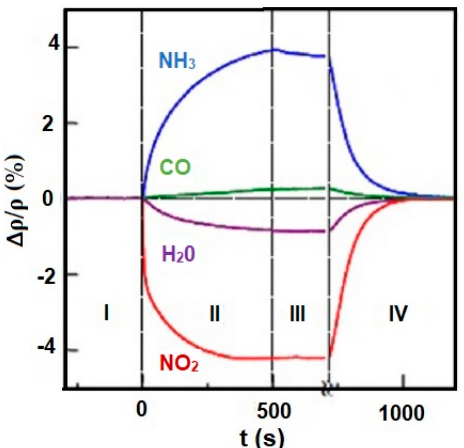
Figure 10. Changes in resistivity ( ρ ) of graphene exposed to NH 3 , CO, H 2 O, and NO 2 . Region I—the device in a vacuum before its exposure, II—exposure to a diluted chemical, III—the erasure of the experimental setup, IV—annealing (150 °C). Reprinted with permission [41].